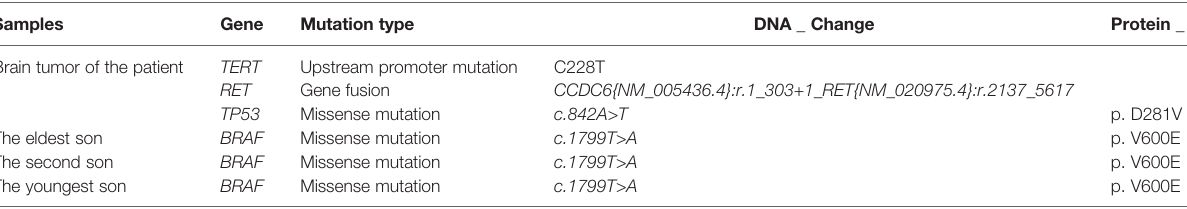
TABLE 1 | NGS Gene Mutation Pro fi ling of tumor tissues.